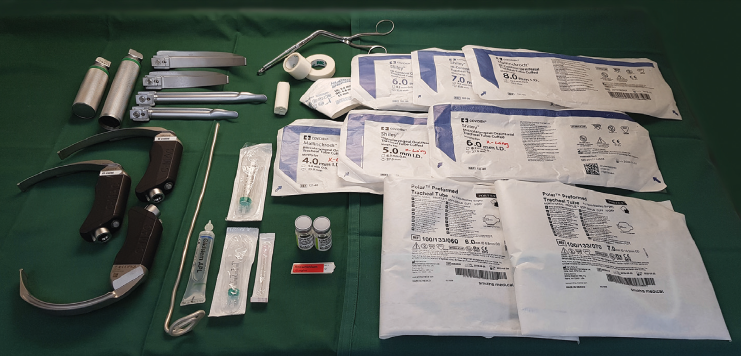
Figure 2: Drawer 1 (plan A)